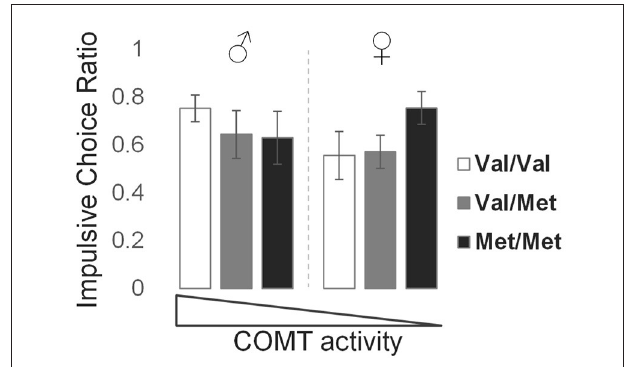
FIGURE 2 | Effects of COMT genotype and sex on impulsive choice during a delay discounting task. Bar graphs represent the mean and standard error of impulsive choice ratio (ICR) values for each group, in order of theoretical frontal dopamine